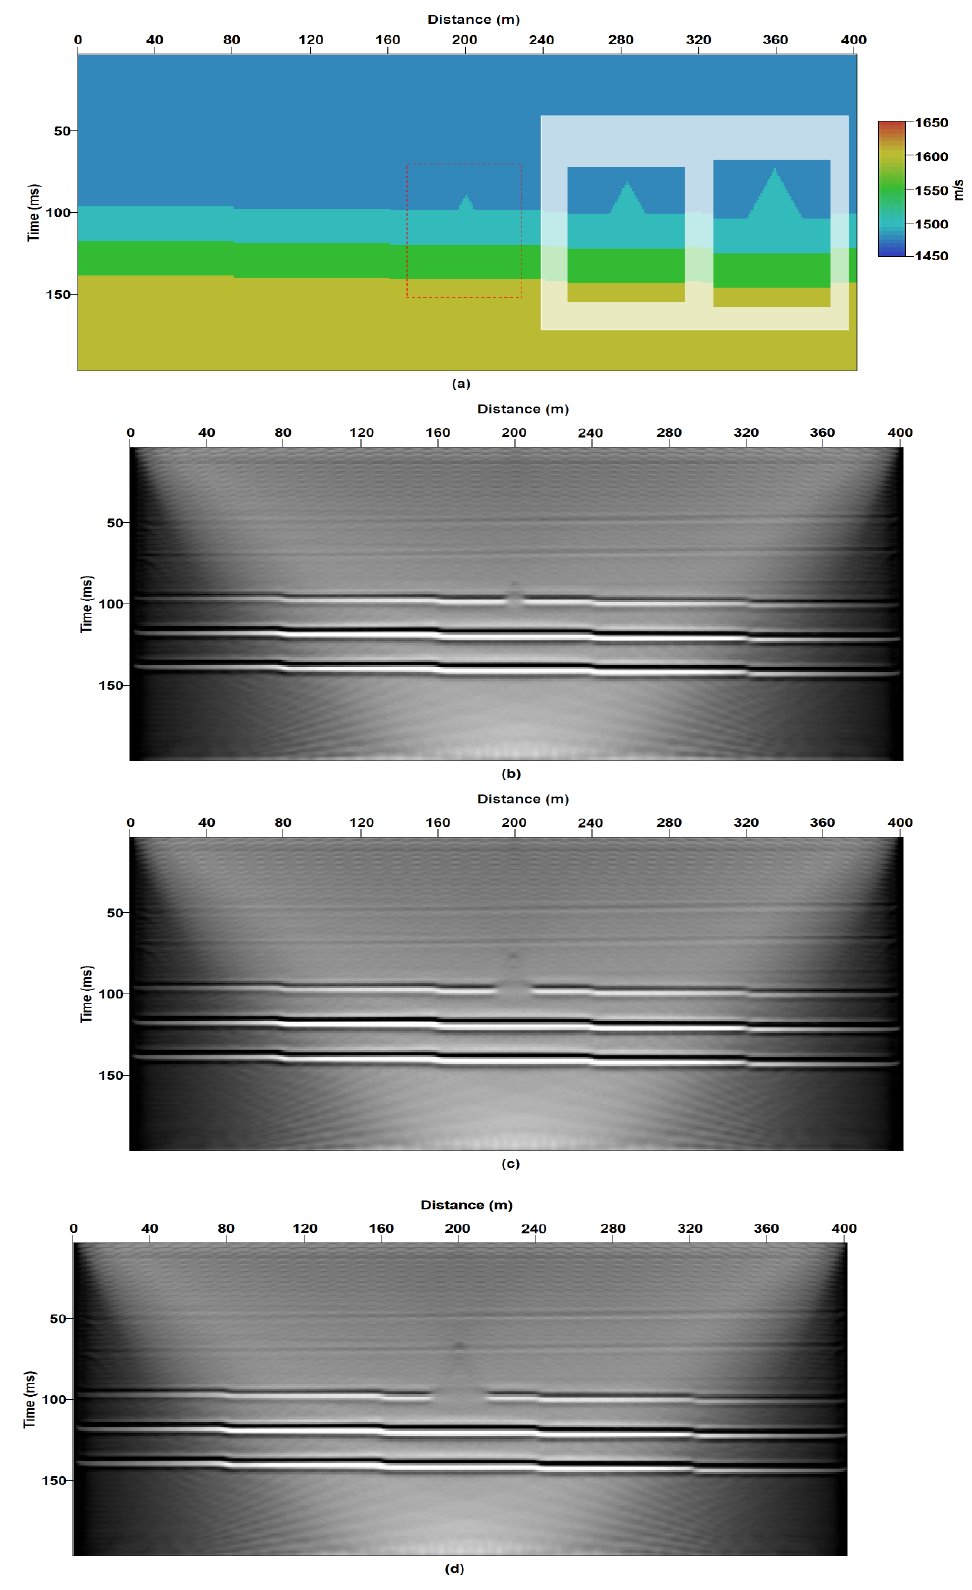
Figure 5. Numerical imaging results: ( a ) input velocity model of topographic variation by assuming the presence of a mound on the seabed; RTM images of ( b ) small; ( c ) medium; and ( d ) large mounds.